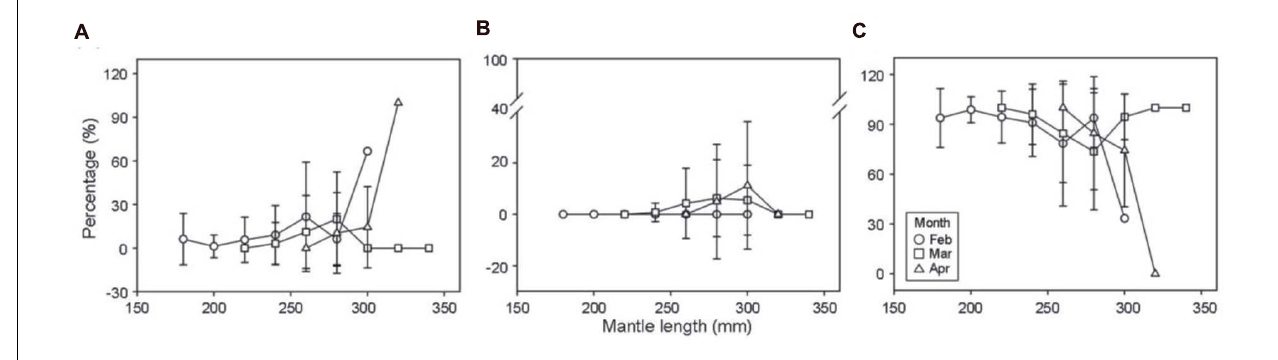
FIGURE 4 | Percentage distributions of the Argentine shortfin squid Illex argentinus with consumed (A) fishes, (B) cephalopods, and (C) crustaceans based on the individual number percentage (mean ± SD) by mantle length for each month in the study area. Squid sizes, ranging between 150 and 350 mm mantle length, are grouped into 20 mm